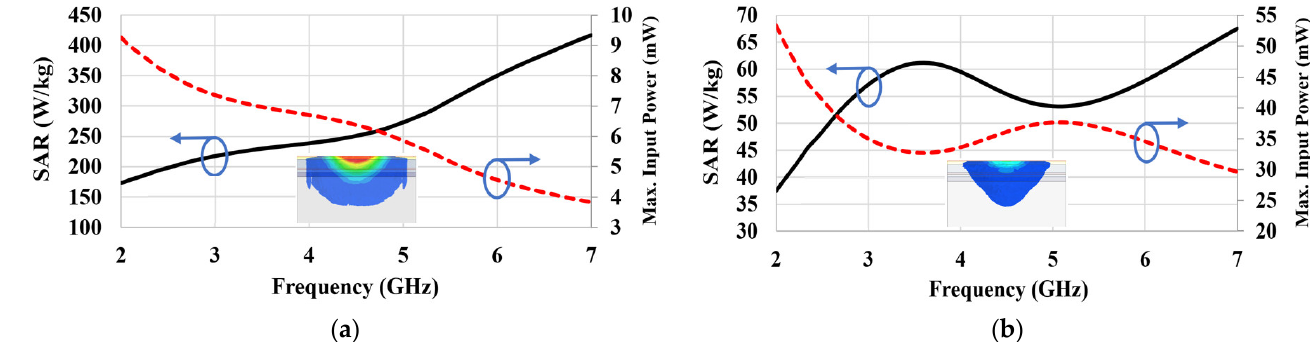
Figure 14. The simulated SAR and maximum allowable input power of the proposed antenna inside the seven-layer phantom: ( a ) SAR-1g and ( b ) SAR-10g. The insets show simulated SAR value distri- butions around the antenna.